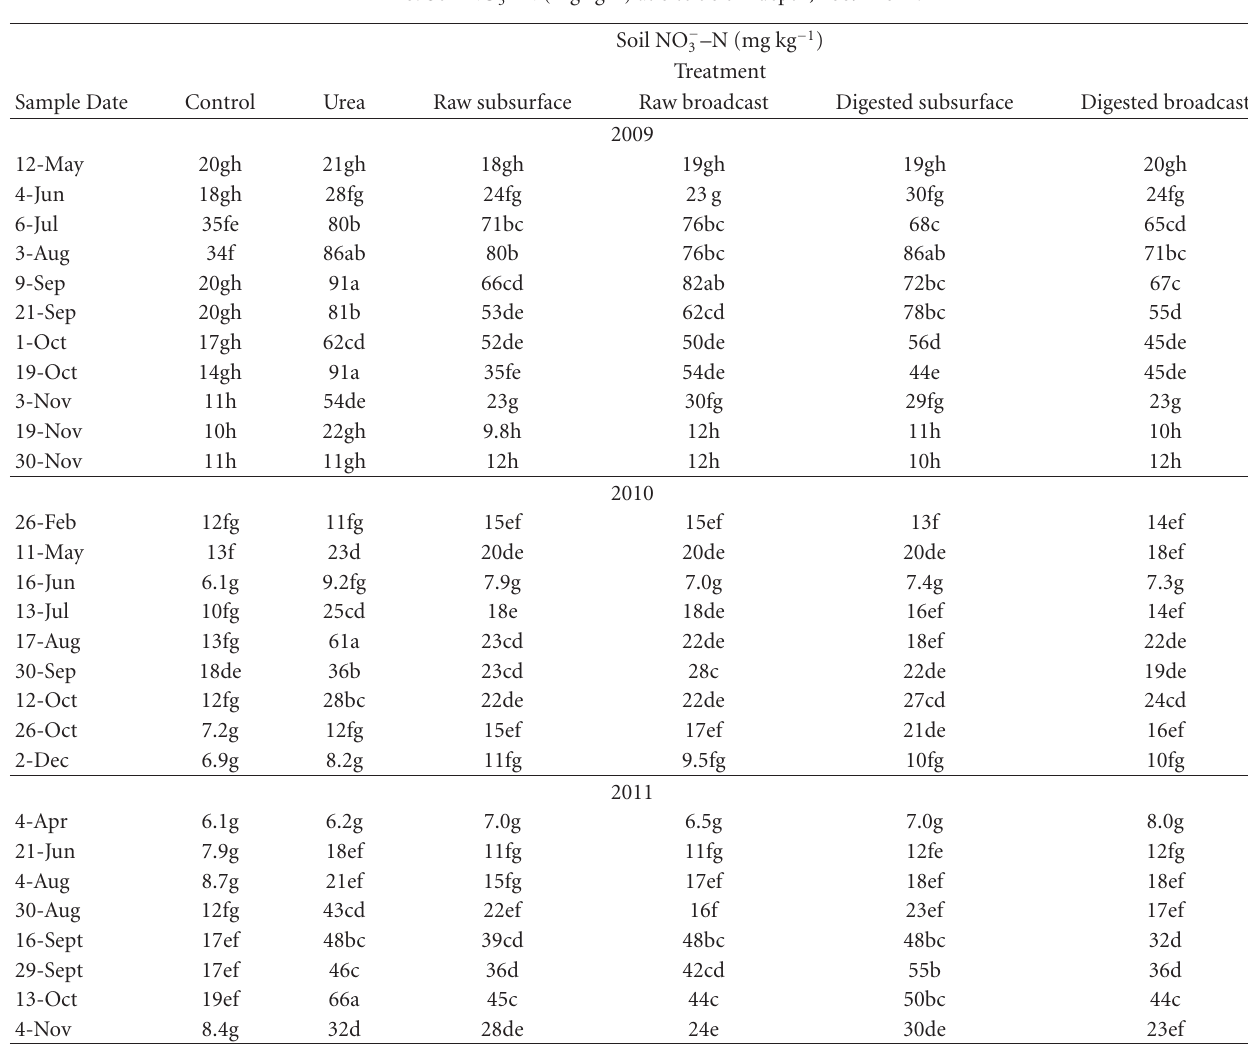
Table 8: Soil NO − –N (mgkg − 1 ) at 0 to 30cm depth, 3